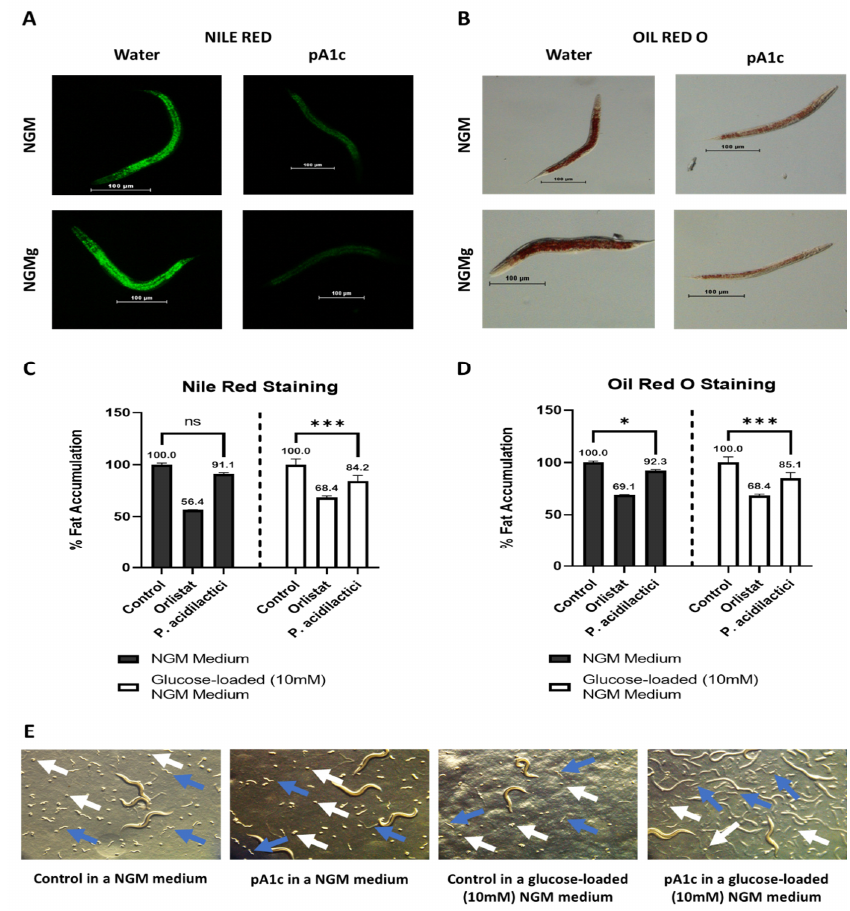
Figure 1. Pediococcus acidilactici reduces fat accumulation in C. elegans ( A ) Nile Red staining of water- and pA1c-treated worms in a NGM medium and in a glucose-loaded (10 mM) NGM medium. ( B ) Oil Red O staining of water- and pA1c-treated worms in a NGM medium and in a glucose-loaded (10 mM) NGM medium. ( C ) Nile Red quantification of water- and pA1c-treated worms (5 × 10 6 CFU) in a NGM medium and in a glucose-loaded (10 mM) NGM medium. ( D ) Oil Red O quantification of water- and pA1c-treated worms (5 × 10 6 CFU) in a NGM medium and in a glucose-loaded (10 mM) NGM medium. Results are expressed as the mean ± standard deviation relative to control worms in a NGM medium or in a glucose-loaded (10 mM) NGM medium. Significance refers to the effect of pA1c with respect to control worms in a NGM medium or in a glucose-loaded (10 mM) NGM medium (Student’s t -Test, * p < 0.05; *** p < 0.001). ( E ) Microscope observation of the presence of eggs (white arrows) and L1 larvae (blue arrows) in both water- and pA1c-supplemented plates in a NGM medium and in a glucose-loaded (10 mM) NGM medium. ns: not